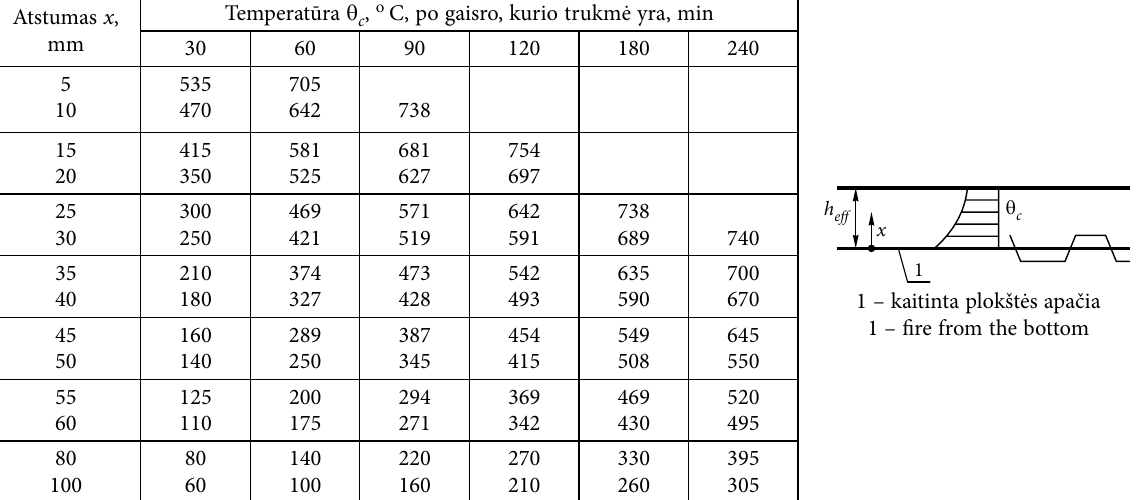
Table 5. Repartition of temperature in a usual 100 thickness concrete slab without any fire protection according to the slab depth Atstumas x